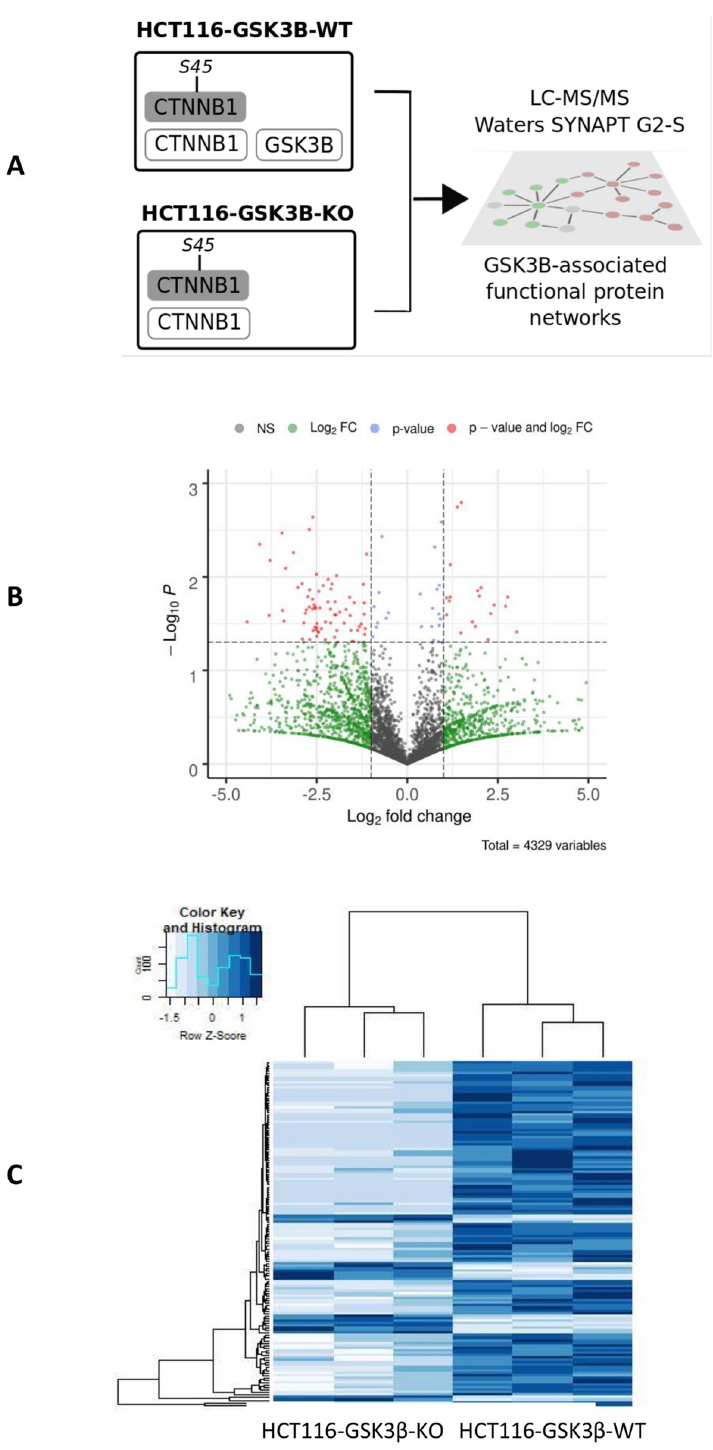
Fig 1. A. Overview of experimental design. HCT116 cells (with stabilizing β -catenin mutation) with wild-type (HCT116-GSK3 β -WT) or knockoutGSK3 β (HCT116-GSK3 β -KO) were profiled using LC-MS/MS to identify associated protein networks. B. Volcano plot of protein expression from mass-spectrometry study. Plot indicates gene symbols for identified proteins with log2 fold-change greater than |2| and p-value < 0.05. C. Heat map of protein expression. Showing replicated wild-type and knockout samples showing those proteins with altered expression (with log2 fold-change greater than |2| and p-value < 0.05).